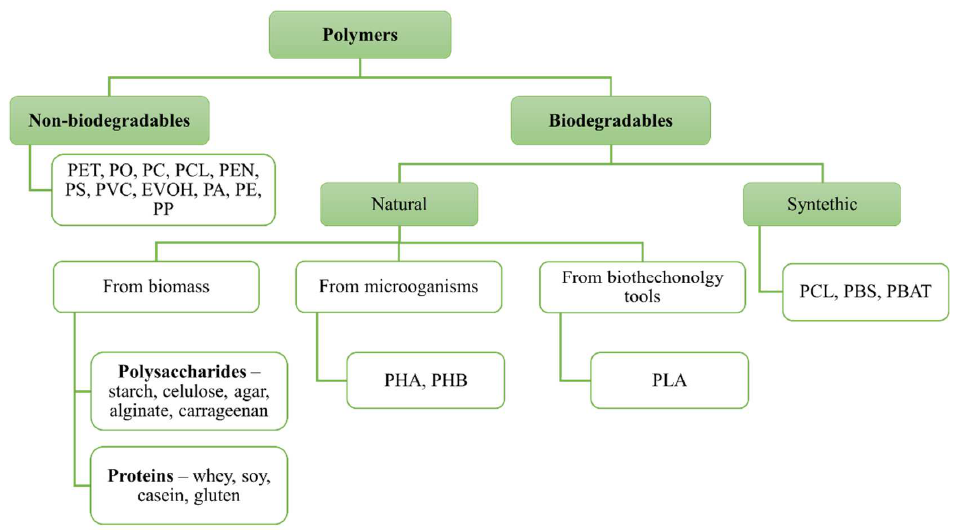
Figure 2. Classification of polymers proposed for food packaging.